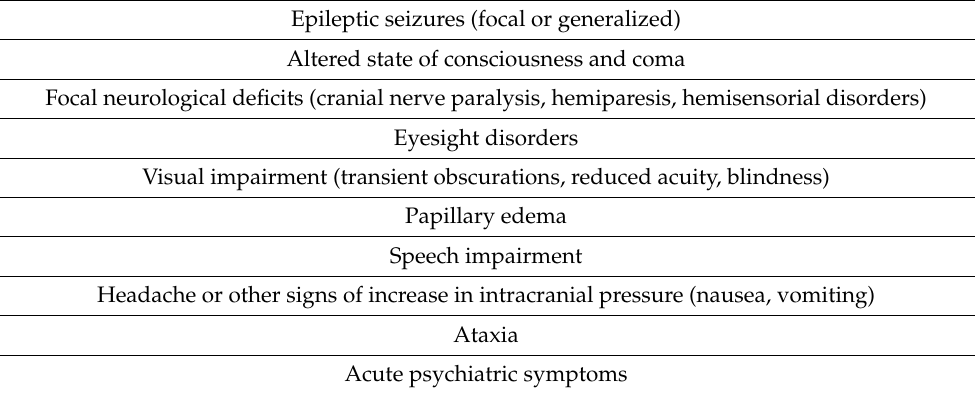
Table 3. Symptoms and signs of cerebral venous thrombosis in